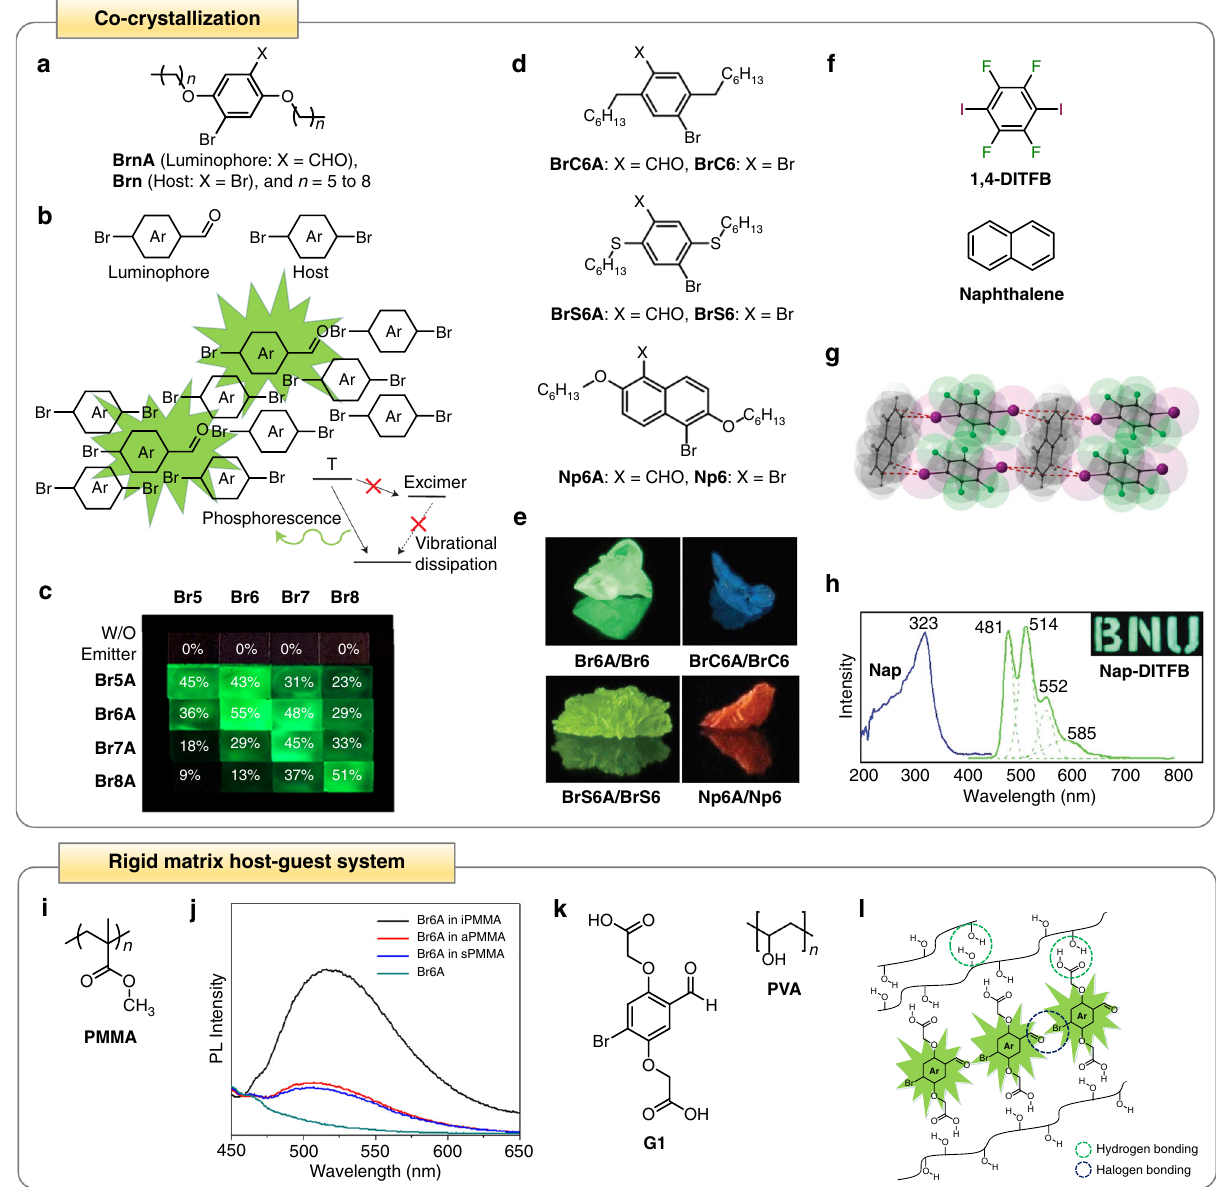
Fig. 3 Enhancement of organic RTP based on co-crystallization and rigid matrix host – guest system. a Chemical structures of a pair of aldehyde luminophore ( BrnA ) and analogous host ( Brn ) used in co-crystallization, where X are CHO and Br for luminophore and host, respectively, and N refers to the alkoxy chain length with varying amount of carbon atoms. b Schematic illustration of the mechanism of RTP enhancement based on co-crystallization, where luminophores (i.e., brominated aromatic aldehydes) are substituted into the host crystals (i.e., dibrominated analogs to the luminophores) and isolated to minimize the excimer-induced self-quenching and enhance the overall RTP quantum yield. c Photographs of the co-crystals formed from BrnA (i.e., Br5A , Br6A , Br7A , and Br8A ) and Brn (i.e., Br5 , Br6 , Br7 , and Br8 ) with different alkoxy chain lengths consisting of fi ve to eight carbon atoms, under 365 nm UV light excitation. The numerical values within the co-crystals indicate their photoluminescence quantum ef fi ciencies. d Chemical structures of different luminophore/host pairs, i.e., BrC6A/BrC6 , BrS6A/BrS6 , and Np6A/Np6 . e Photographs of the co-crystals mixed from Br6A/Br6 , BrC6A/BrC6 , BrS6A/ BrS6 , and Np6A/Np6 combinations under 365-nm UV light irradiation. f Chemical structures of 1,4-DITFB and Naphthalene. g Packing structure of the